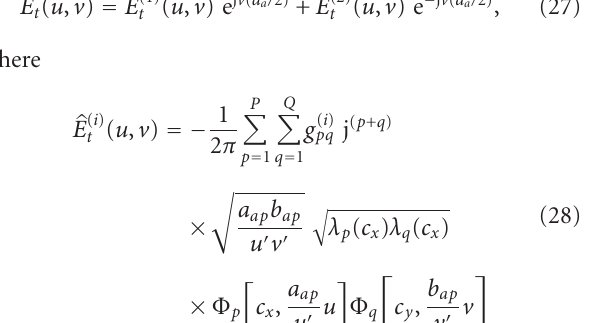
Figure 3: Pictorial view of the measurement